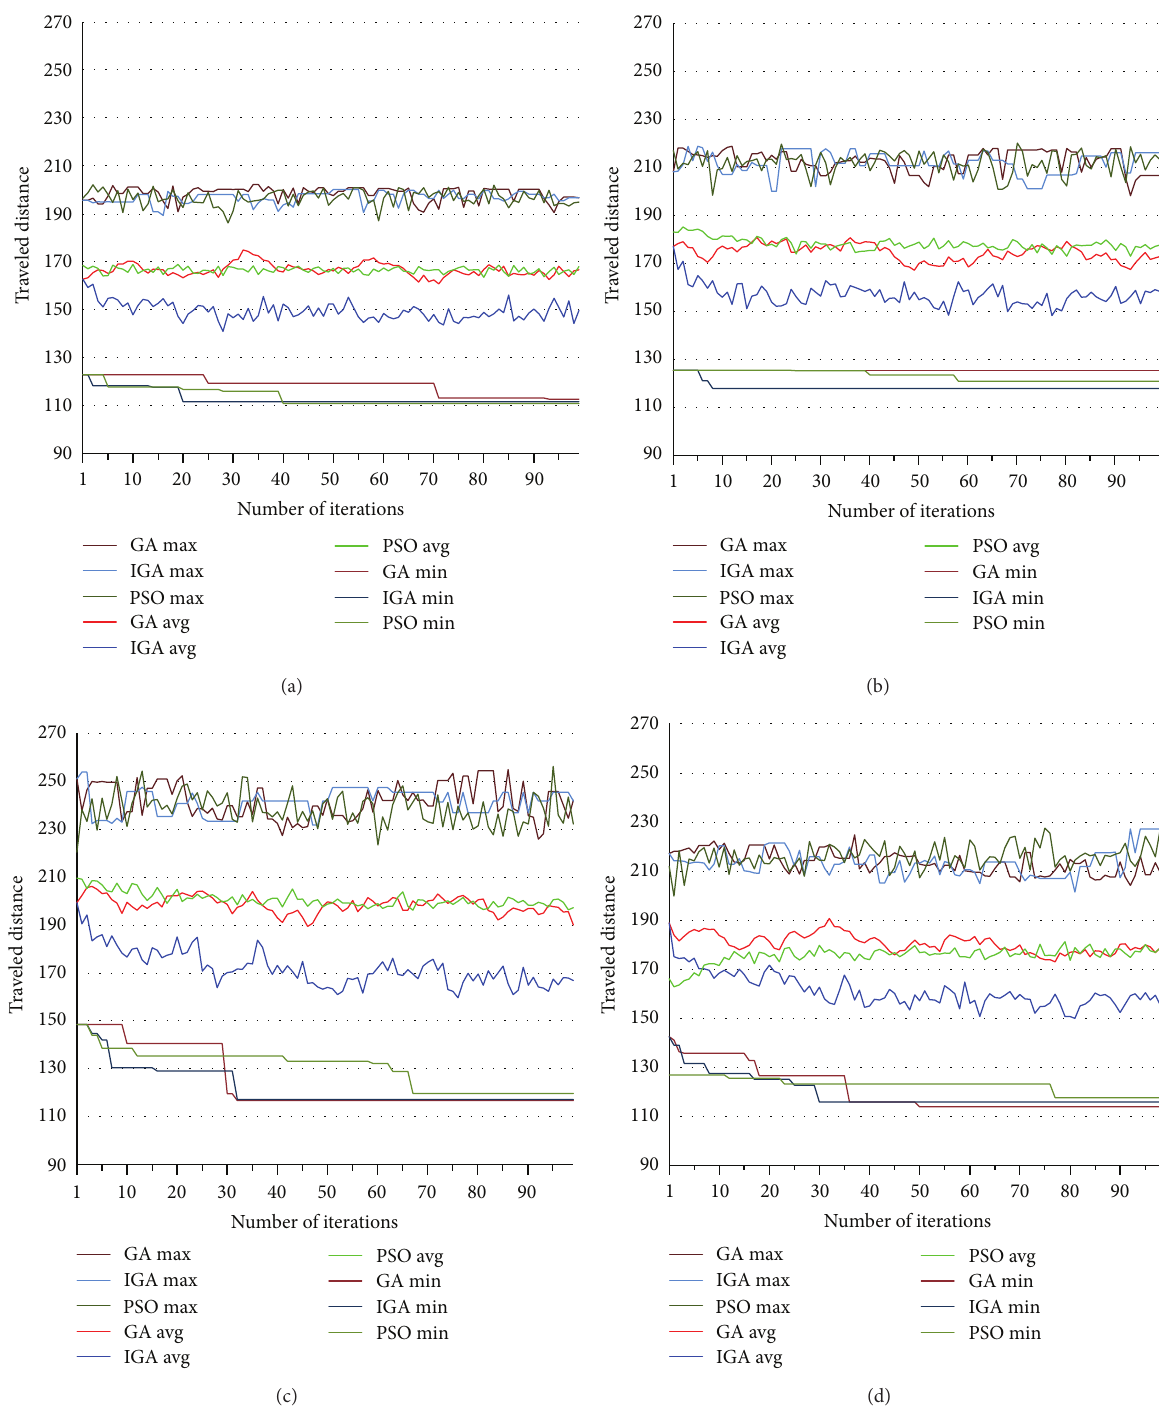
Figure 8: The shortest traveled distance for simulation results for Case 2. 5 goods overlap by GA, IGA, and PSO. (a) Goods type A, (b) goods type B, (c) goods type C, and (d) goods type